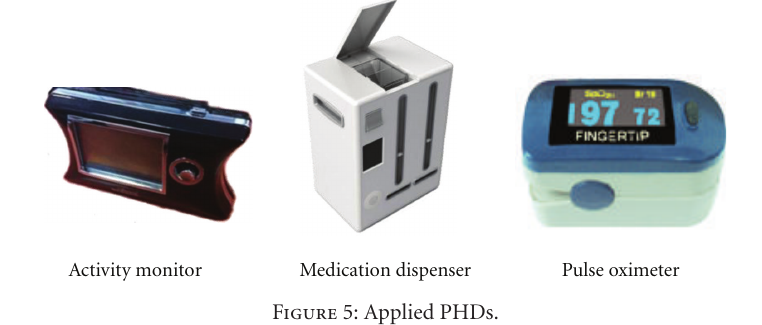
Figure 5: Applied PHDs.